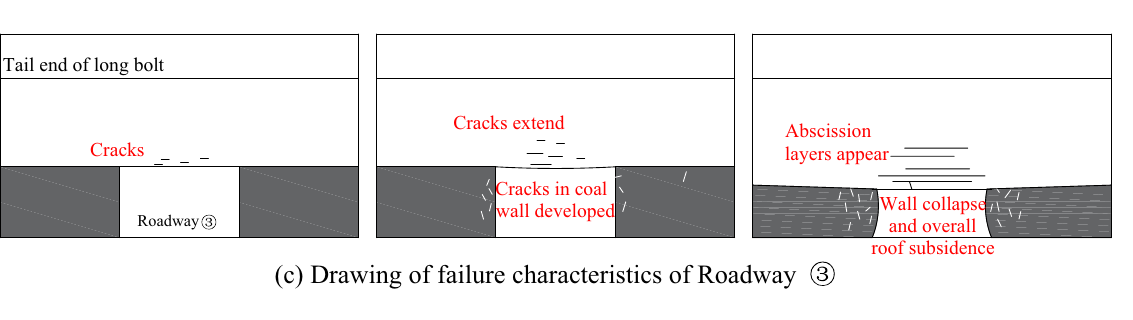
Figure 20. Drawings of failure characteristics of each